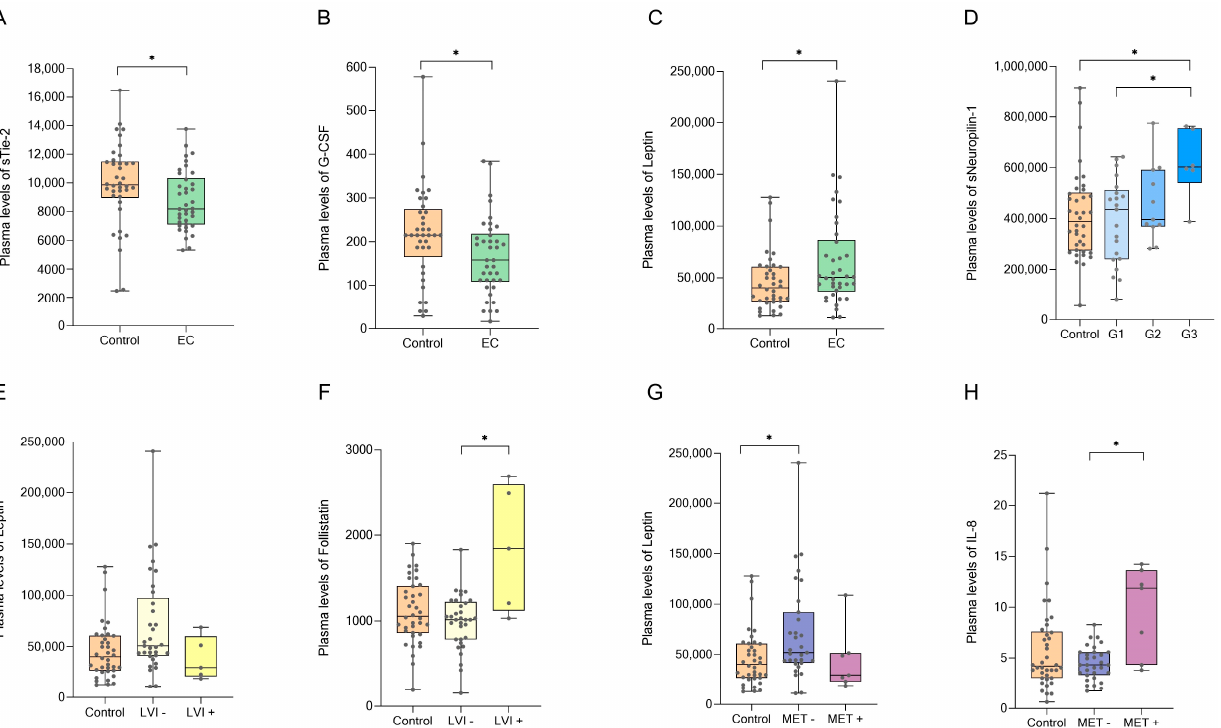
Figure 2. Box plots (min to max with all points shown) comparing plasma levels of angiogenic biomarkers (pg/mL) between study groups. ( A – C ) Control and endometrial cancer (EC) patients. ( D ) Control patients and patients with different grades of EC. ( E , F ) Control patients and patients with or without lymphovascular invasion (LVI). ( G , H ) Control patients and patients with or without metastasis (MET). * signifies p < 0.05.